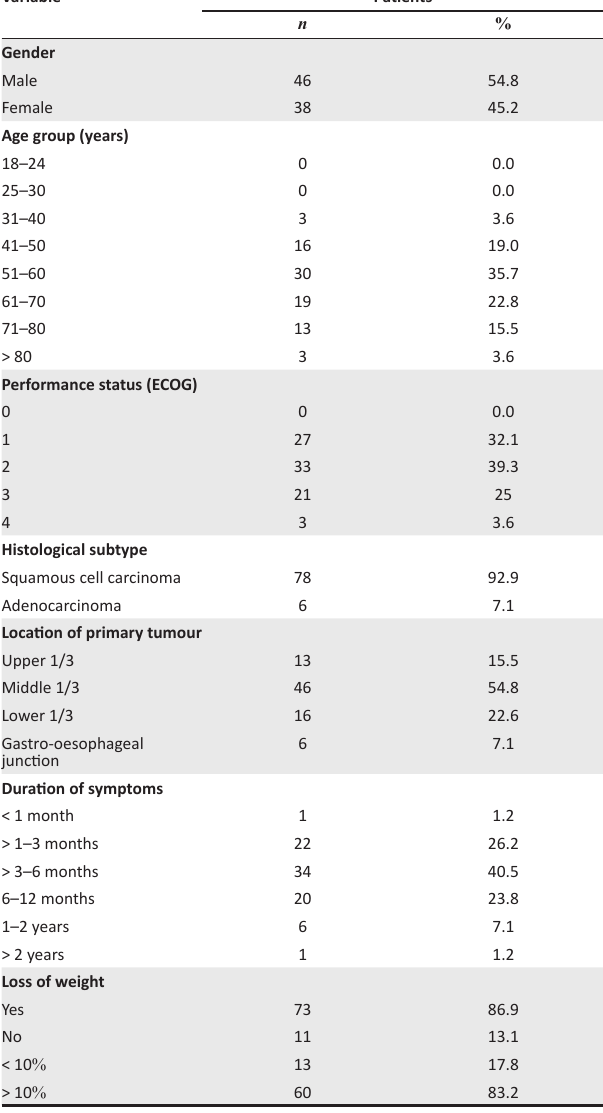
TABLE 1: Demographics and disease-related variables in the study